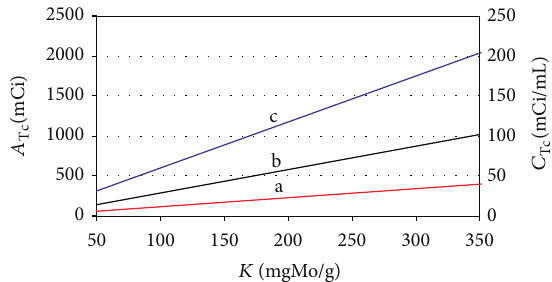
) and 99 m Tc- Figure 7: Assessment on the 99 m Tc-radioactivity (𝐴 Tc ) of the eluate eluted from the generators of concentration (𝐶 Tc 5-gram weight column-packing materials of variable Mo-loading capacity 𝐾 (low specific activity 99 Mo solutions used are produced in the nuclear reactors: (a) thermal neutron flux Φ = 2.1013 n ⋅ cm −2 ⋅ sec −1 ; (b) Φ = 5.1013 n ⋅ cm −2 ⋅ sec −1 ; (c) Φ = 1014 n ⋅ cm −2 ⋅ sec −1 . The saline eluate volume is 10